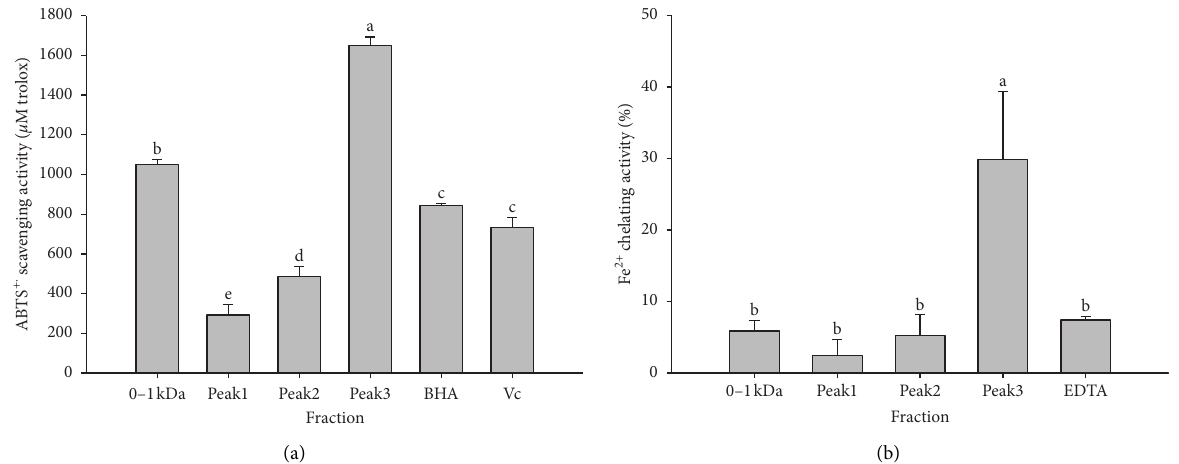
Figure 3: ABTS + • scavenging activity (a) and metal chelating activity (b) of gel filtration fractions from PPH ultrafiltration fractions passing the membrane with the molecular weight cut-off of 1kDa at the protein concentration of 1mg/mL (the concentrations of BHA, Vc, and EDTA were 0.1, 0.05, and 1mg/mL,